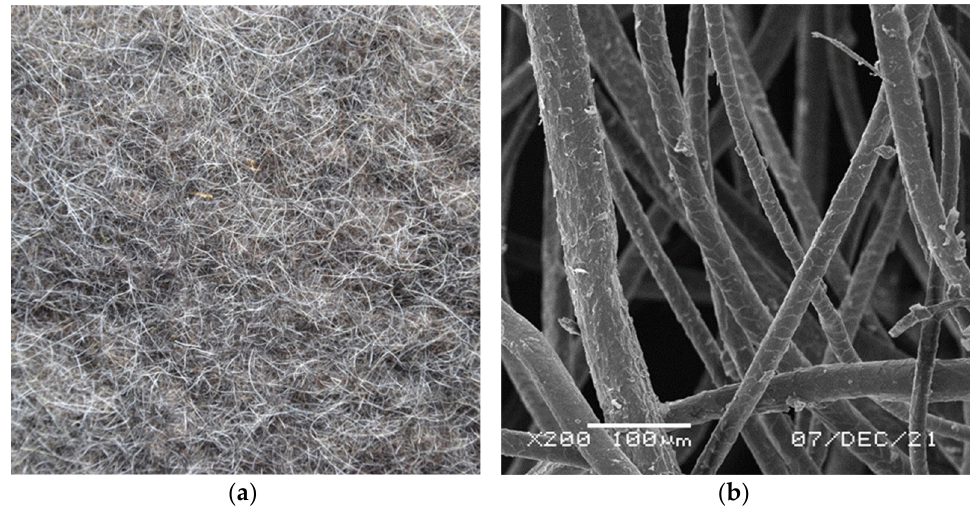
Figure 11. Wool felt; ( a ) tangled fibres on the surface; ( b ) fibres of different thickness covered with scales.